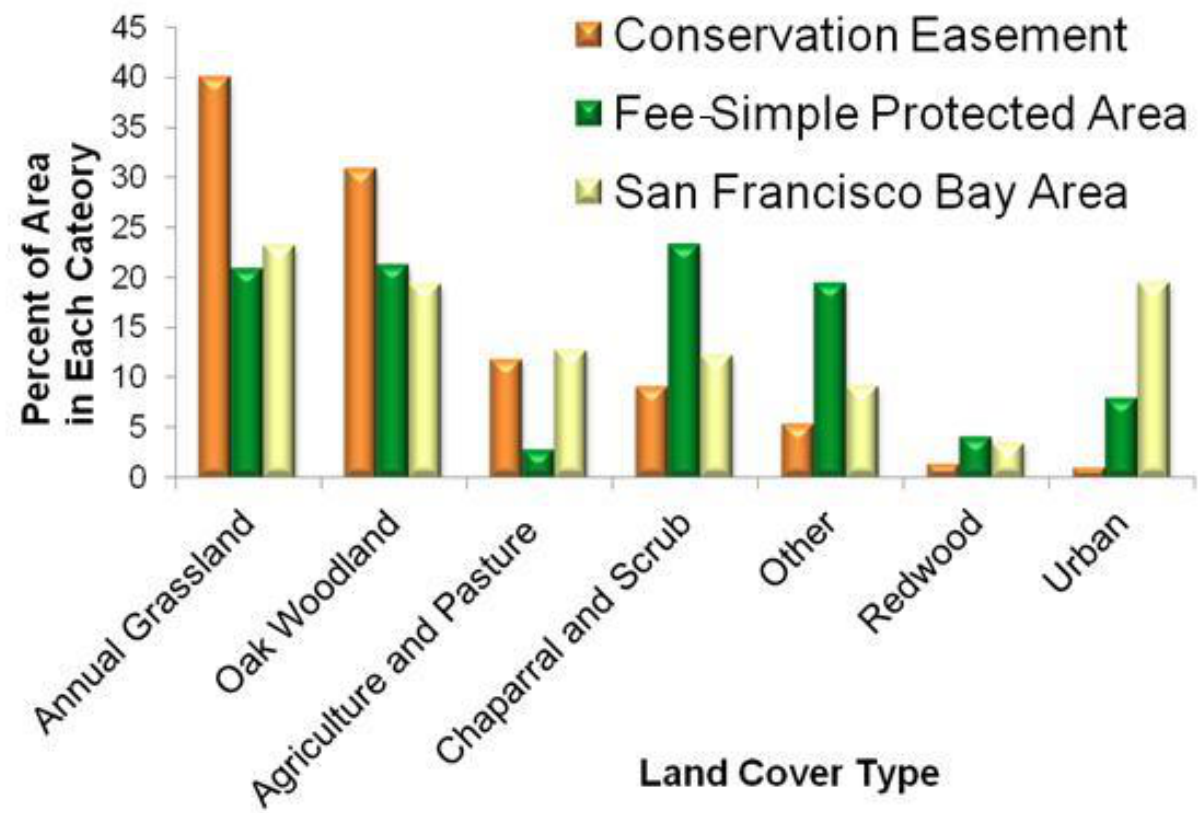
Fig. 6 . Vegetation types that occurred in conservation easements, fee-simple properties, and all land in the nine-county San Francisco Bay